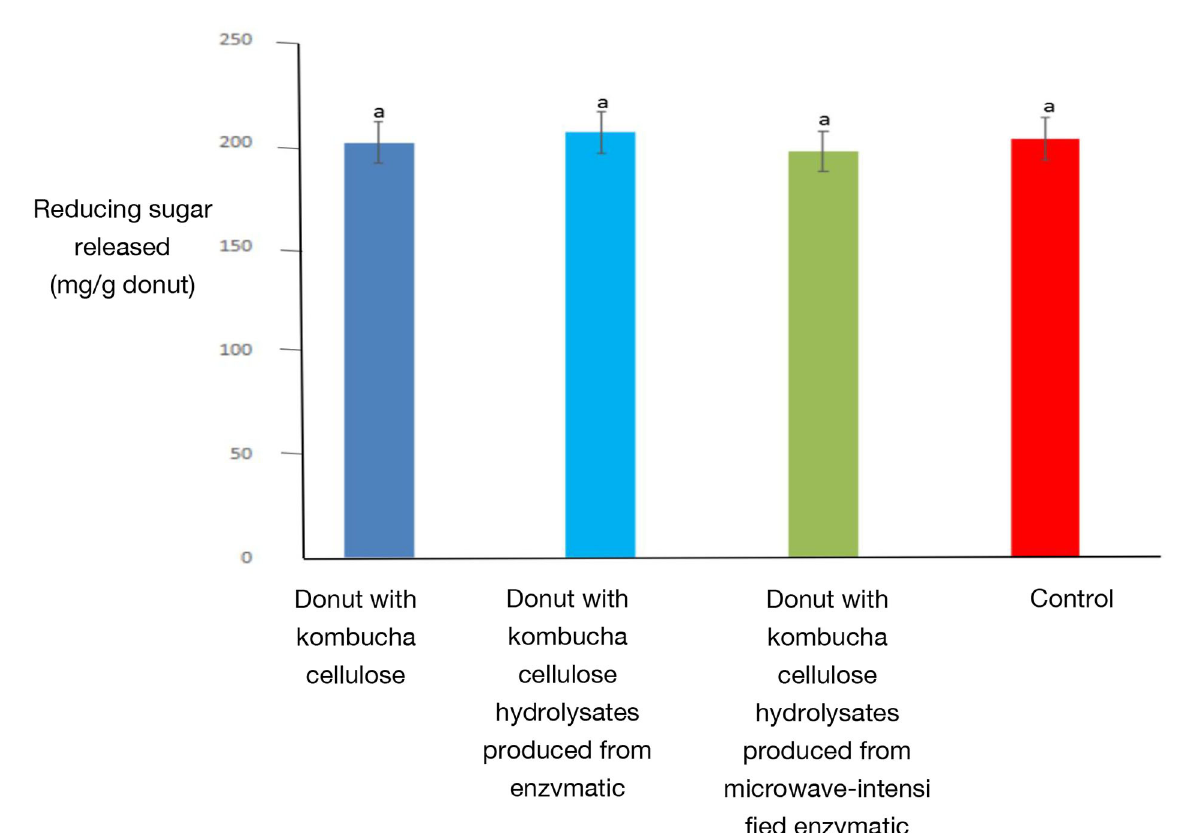
FIGURE5 The AUC of deep-fried donuts produced by different treatments. Error bars represent the standard deviation of replicates ( n = 3). Values with different letters indicate significant differences ( p < 0.05). Minitab was used to apply a one-way analysis of variance (ANOVA) and the least significant difference (LSD).Within each trial, different letters indicate significant differences ( p < 0.05), according to one-way ANOVA and LSD